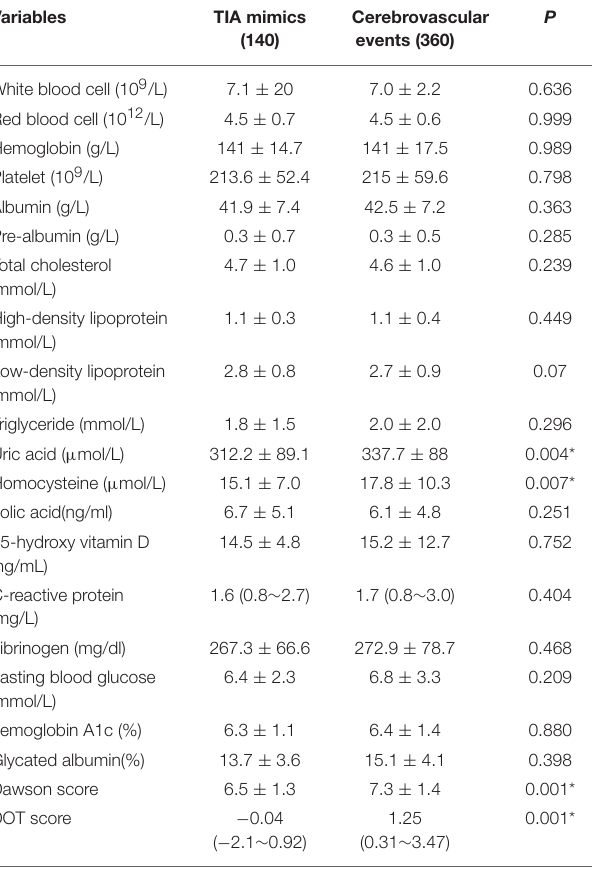
Values represent number (percent) for categorical variables and mean ± SD or median (interquartile range) for continuous variables. * P < 0.05. DOT, diagnosis of